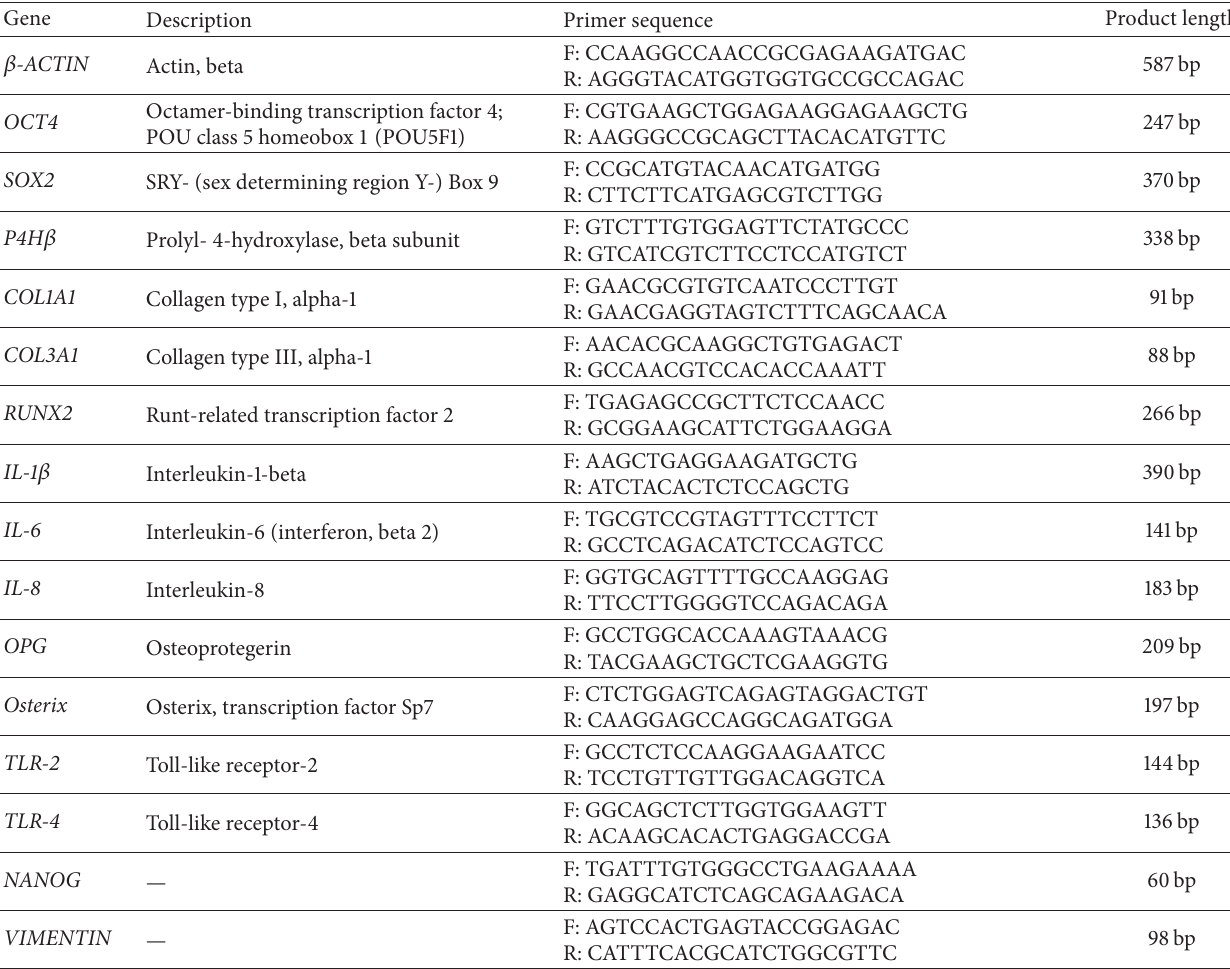
Table 1: Primer sequences used for real-time